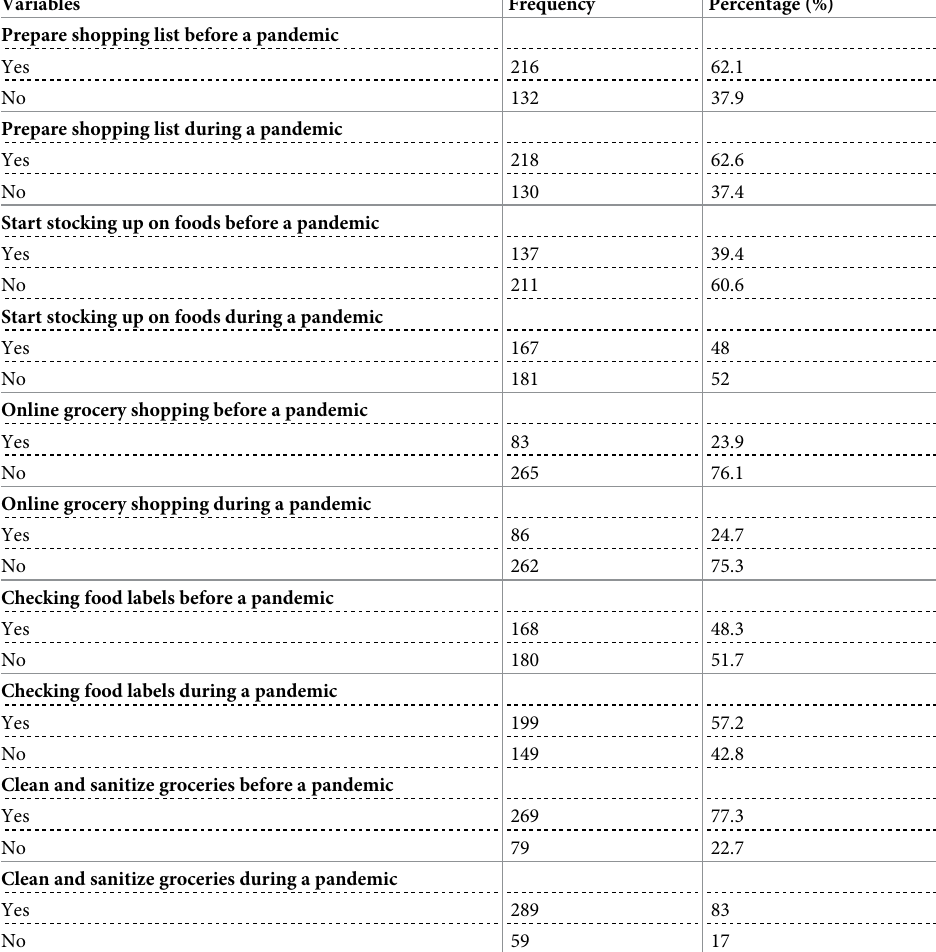
Table 5. Shopping practices during COVID-19 pandemic (n =